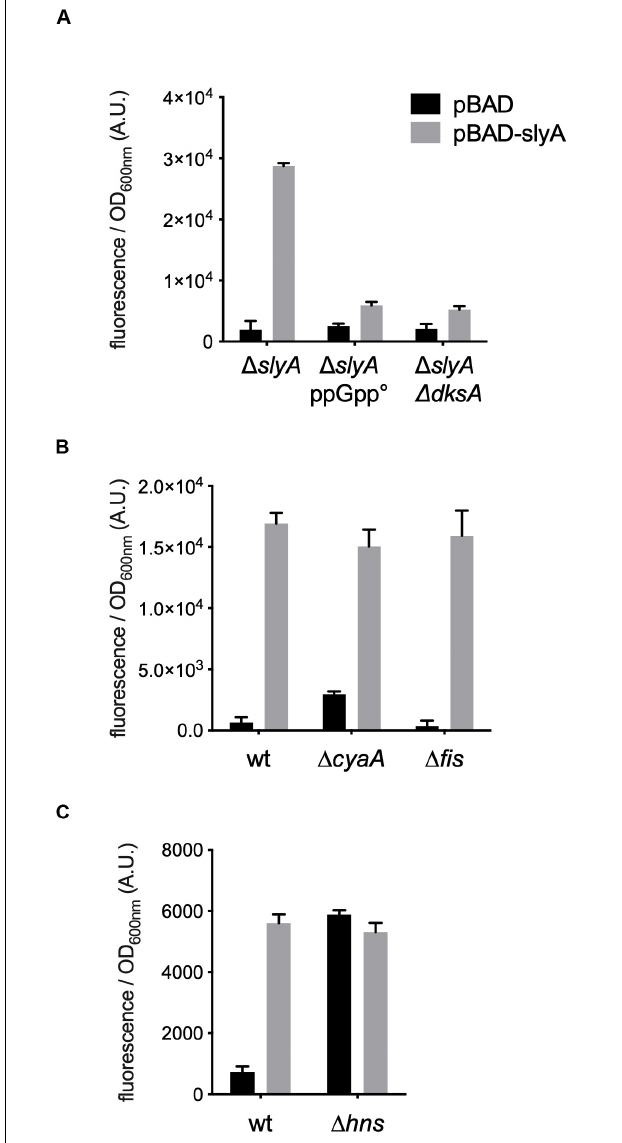
FIGURE 3 | hlyE activation by SlyA in global regulatory mutants. Induction of the hlyE transcriptional fusion by pBAD-slyA_ecoli was tested in the same conditions as in Figure 1B , in the indicated mutant strains: wt (MG1655), (cid:49) slyA (EB1073), (cid:49) slyA_ ppGpp (EB1077), (cid:49) slyA (cid:49) dksA (EB1100), (cid:49) cyaA (EB781), (cid:49) fis (EB743), and (cid:49) hns (EB951). The activities correspond to the ratio between GFP fluorescence and OD 600 nm of 4 (A,C) or 3 (B) replicates, given in arbitrary units (A.U.). The error bars show the SEM.